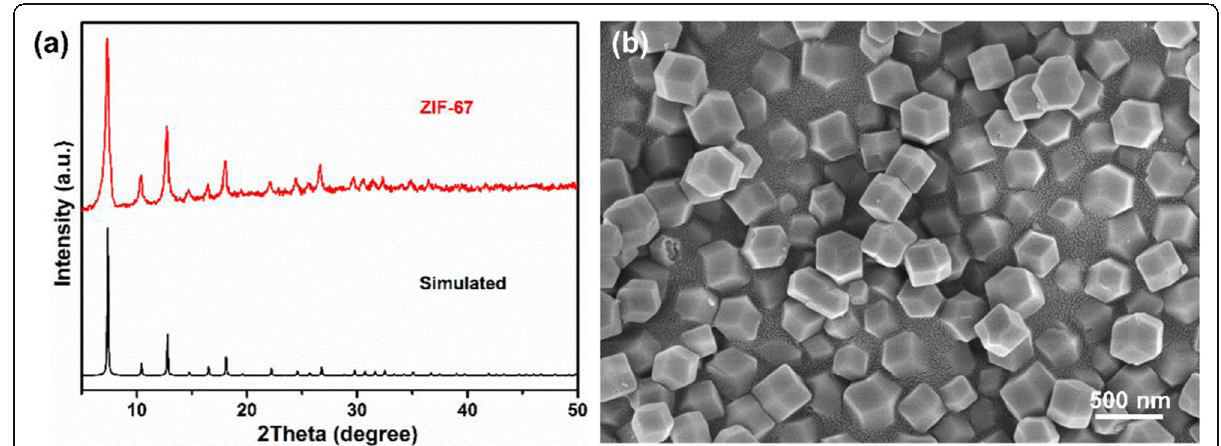
Fig. 2 a XRD patterns of as-synthesized ZIF-67 and simulated XRD patterns of ZIF-67. b SEM image of as-synthesized